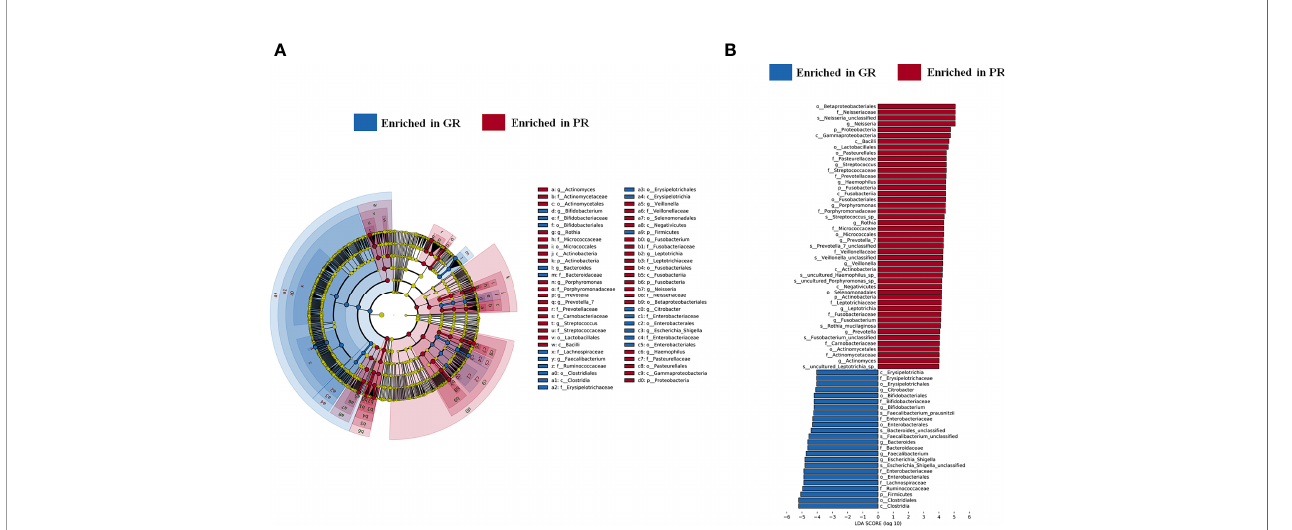
FIGURE 4 | Marked differences in the abundance of gut microbiome at all taxonomic levels between GR and PR groups obtained by using the linear discriminant analysis (LDA) effect size (LEfSe) method; (A) The enriched taxa in GR and PR gut microbiome represented in the cladogram. The central point represents the root of the tree (Bacteria), and each ring represents the next lower taxonomic level (phylum to genus: p, phylum; c, class; o, order; f, family; g, genus). The diameter of each circle represents the relative abundance of the taxon. (B) Histogram of the LDA scores computed for differentially abundant taxa between GR and PR. The LDA score indicates the effect size and ranking of each differentially abundant taxon. P < 0.01, LDA >4. PR, poor response; GR, good